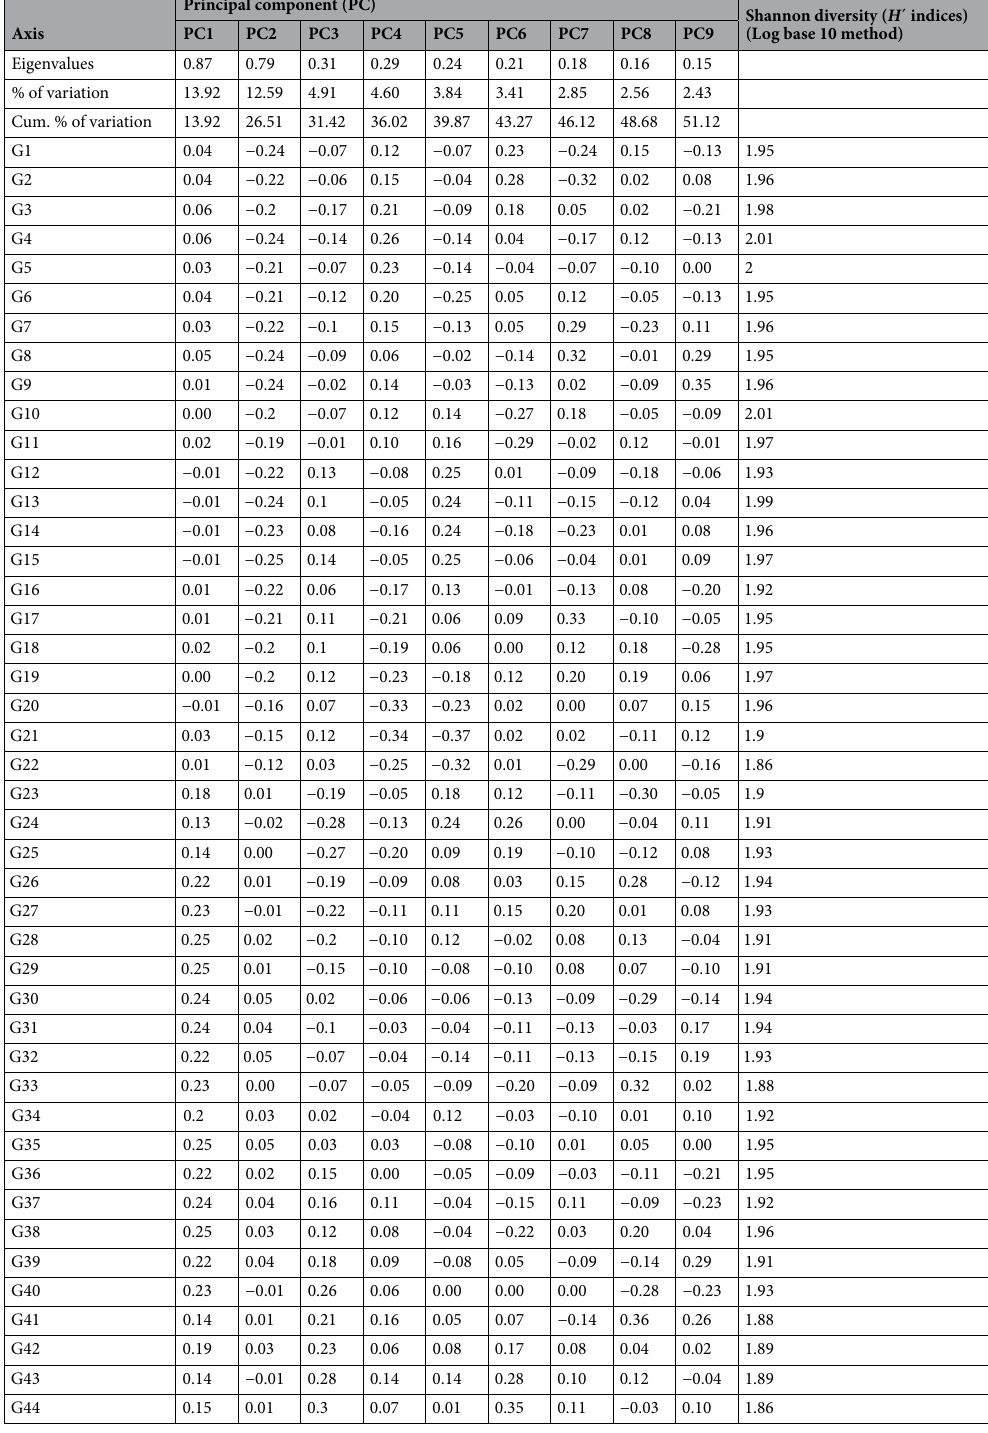
Table 5. H ˊ index, eigenvalues and percentage of total variation contributed by principal component (PCs). PC principal component, CUM